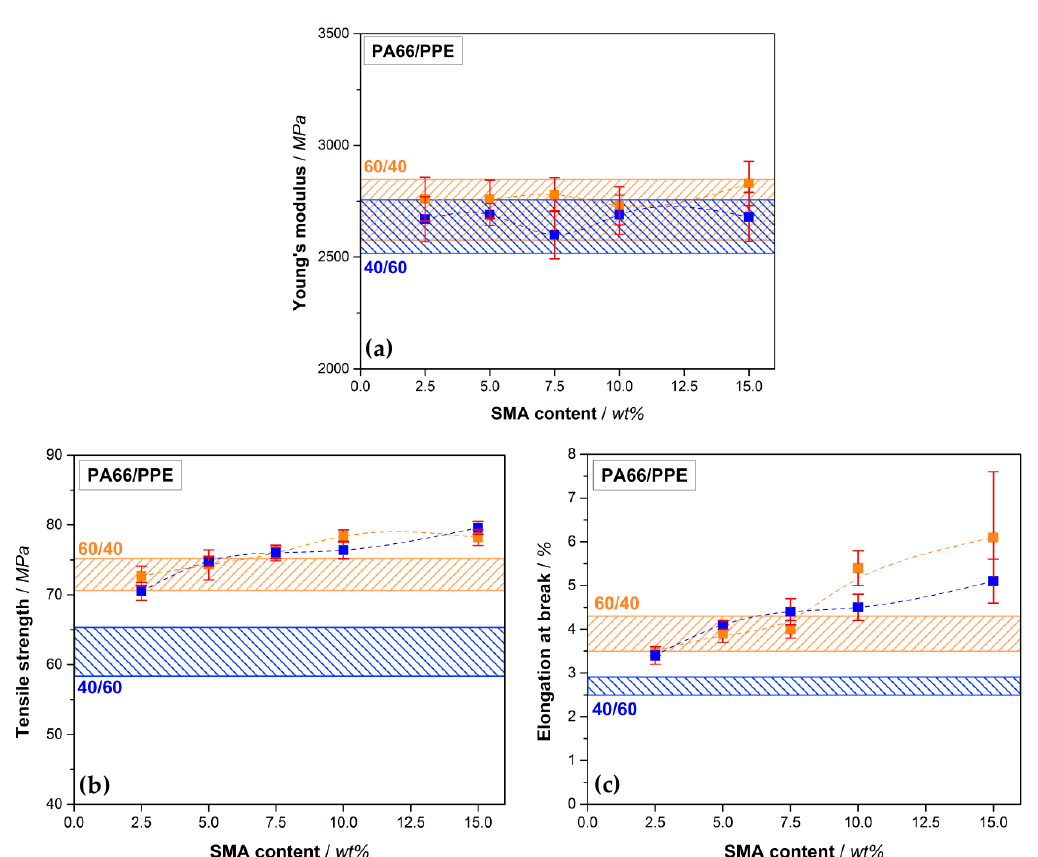
Figure 5. Tensile properties of PA66/PPE/SMA ternary blends with Young’s modulus ( a ), tensile strength ( b ) and elongation at break ( c ), depending on the SMA content, with 60/40 blend ratio (orange rectangular) and 40/60 blend ratio (blue rectangular). Orange (60/40) and blue bars (40/60) stand for the PA66/PPE binary blend values without SMA.